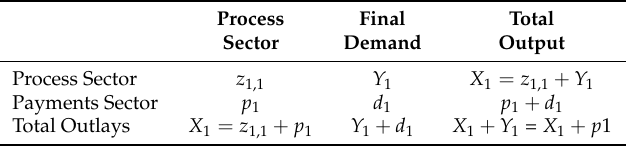
Table 1. A one-sector I-O model demonstrates the normal assumptions for the construction of an I-O table with intermediate transactions matrix Z , net output Y and gross output X . Note: a 1,1 = z 1,1 / X 1